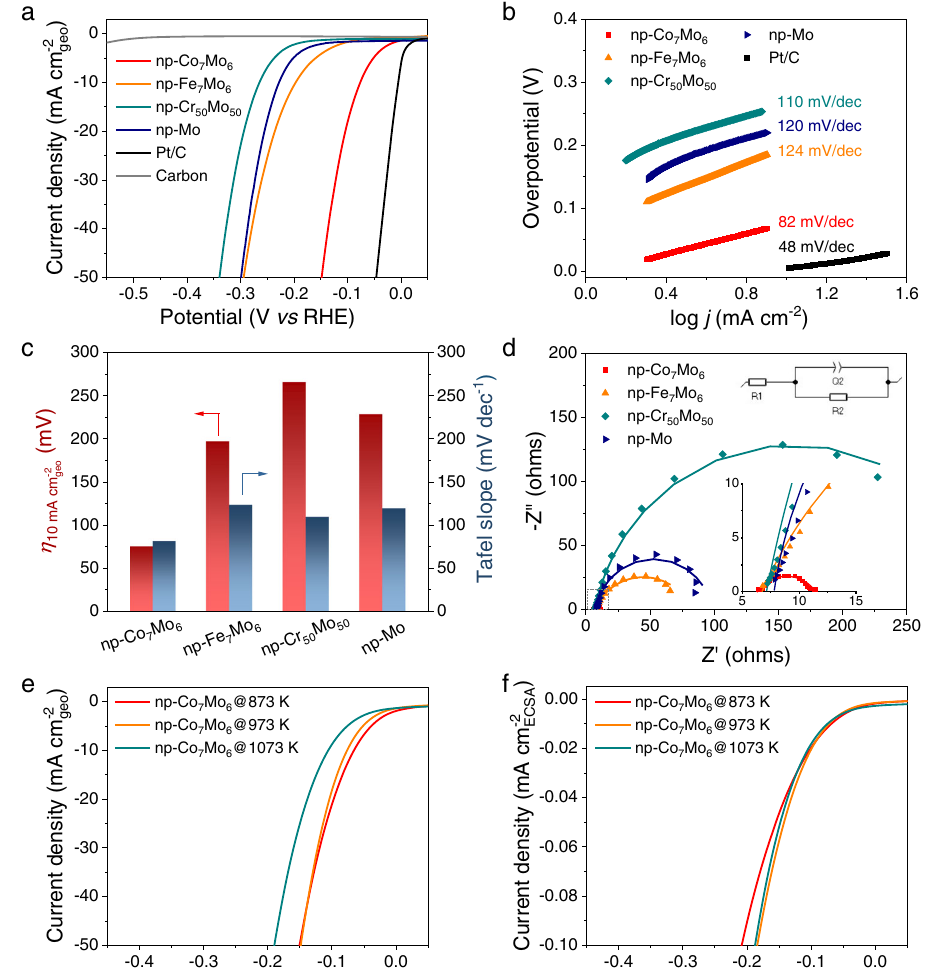
Fig. 5 | Electrochemical HER performance of the nanoporous Mo-based inter- metallic compounds and the reference materials tested as powder samples cast on a disk electrode. a iR-corrected HER polarization curves. b Tafel plots. c Comparisons of overpotential at 10mAcm − 2 geo current density and Tafel slopes. d EISspectracollectedat200mVoverpotential.Theinsetsarethezoom-inspectra